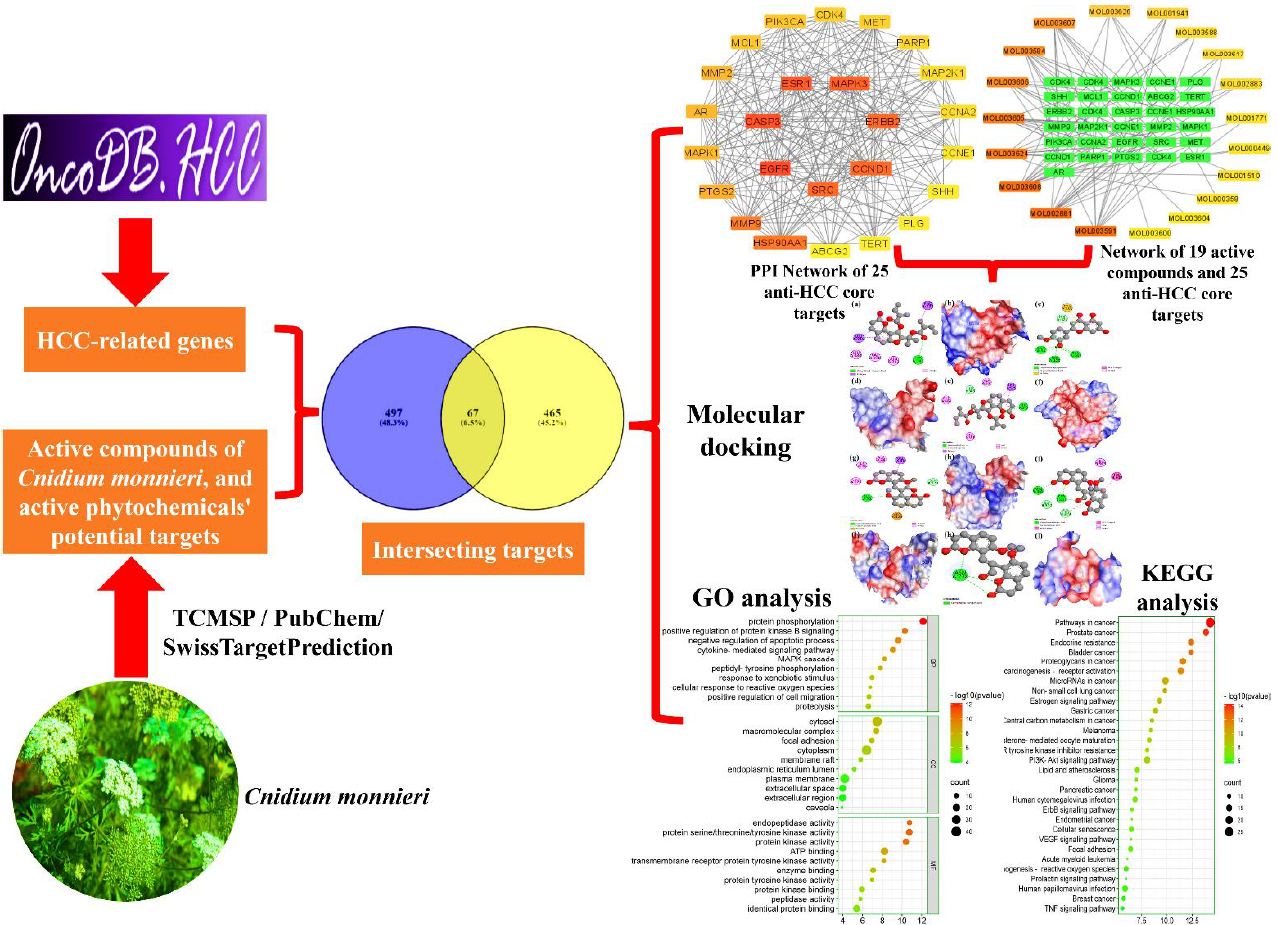
Figure 1. Flowchart of the current research study.